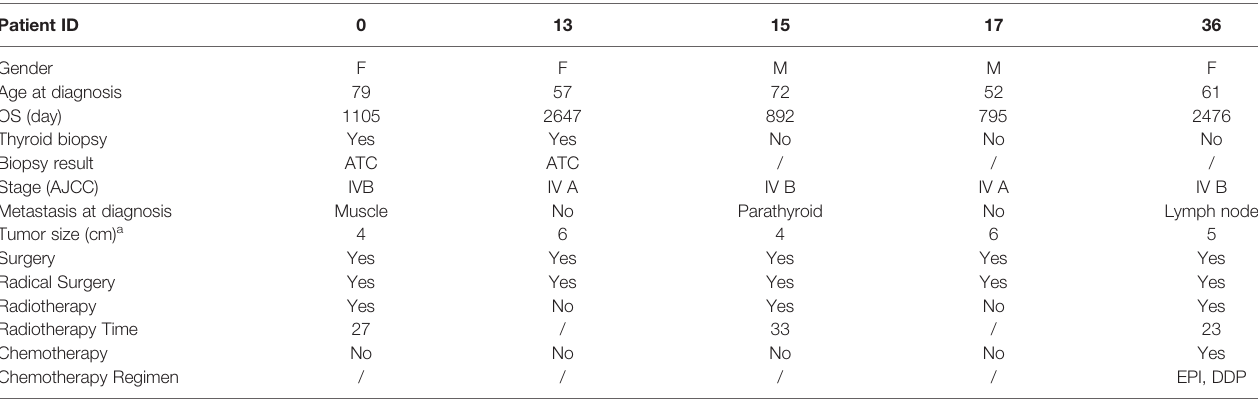
TABLE 1 | Survivor